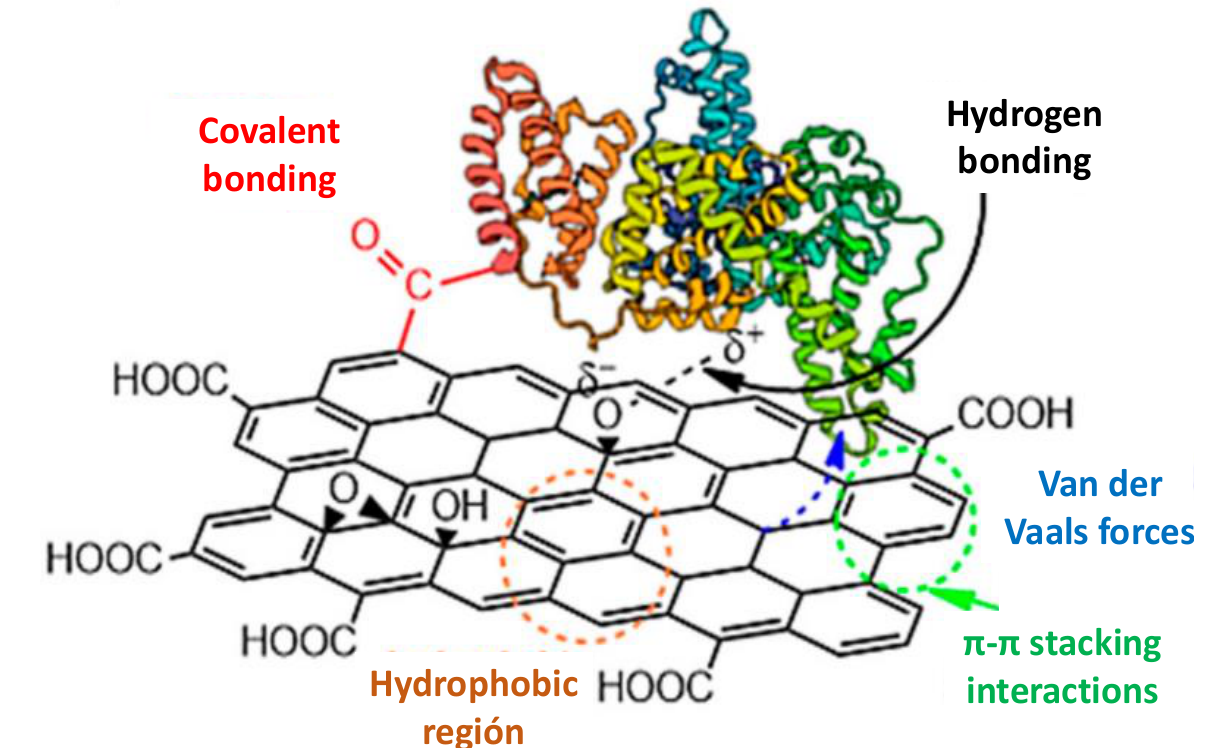
Figure 7. Non-covalent interactions between graphene and polymers. Adapted from [36]. Taking into account these interactions, three different structures can be observed in graphene/polymer nanocomposites: phase separated, intercalated, and exfoliated (Figure 8). Intercalation is the desirable to occur, in which the polymer inserts into the spaces between the nanomaterial sheets. However, exfoliation is the most favorable, since the polymer is completely distributed within the individual nanometer layers.